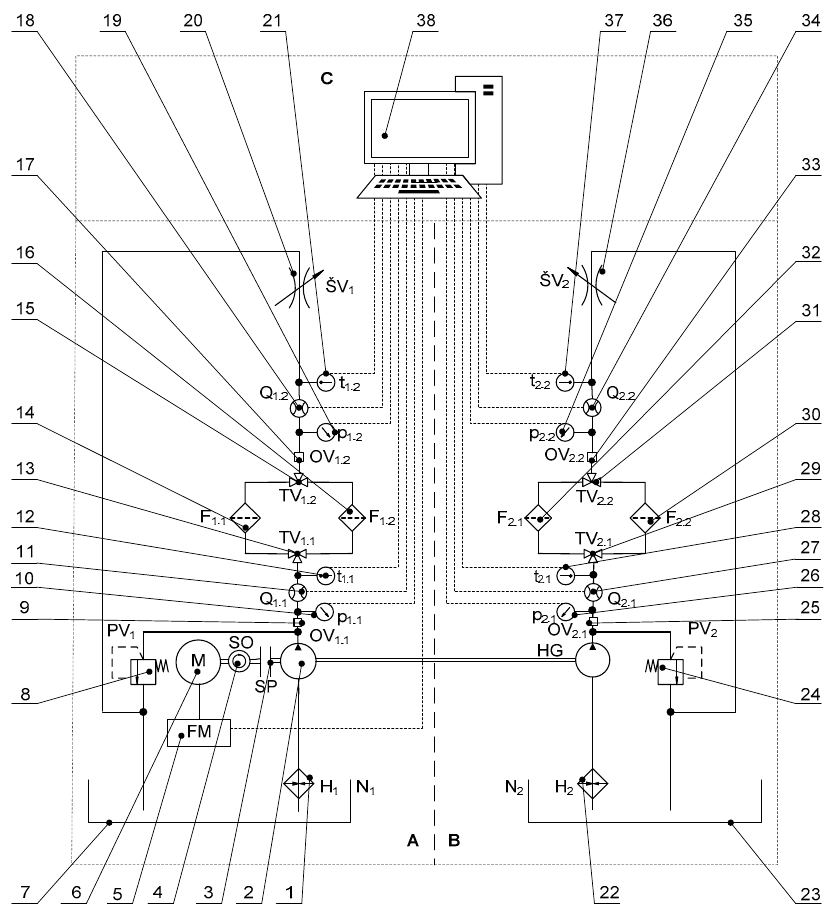
Figure 1. Equipment for comparing the flow properties of oil filter materials in the lubrication circuits of internal combustion engines. Legend: A-reference measuring circuit, B-test measuring circuit, C-recording# and evaluation circuit. 1, 22-heaters; 2-tandem hydraulic pump; 3-coupling; 4-speed sensor; 5-frequency converter; 6-electric motor, 7, 23-tanks; 8, 24-safety valves; 10, 19, 26, 35-pressure sensors; 11, 18, 27, 34-flow sensors; 12, 21, 28, 37-temperature sensors; 13, 15, 29, 31-three-way valves; 14, 32-original filter materials; 16, 30-tested filter materials; 9, 17, 25, 33-sampling points; 20, 36-throttle valves; 38-computer with software; HG-tandem hydraulic pump; H 1 , H 2 -heaters; N 1 , N 2 -tanks; FM-frequency converter; SP-coupling; SO-speed sensor; PV 1 , PV 2 -safety valves; Q 1.1 , Q 1.2 , Q 2.1 , Q 2.2 -flow sensors; p 1.1 , p 1.2 , p 2.1 , p 2.2 -pressure sensors; t 1.1 , t 1.2 , t 2.1 , t 2.2 -temperature sensors; F 1.1 , F 1.2 ,